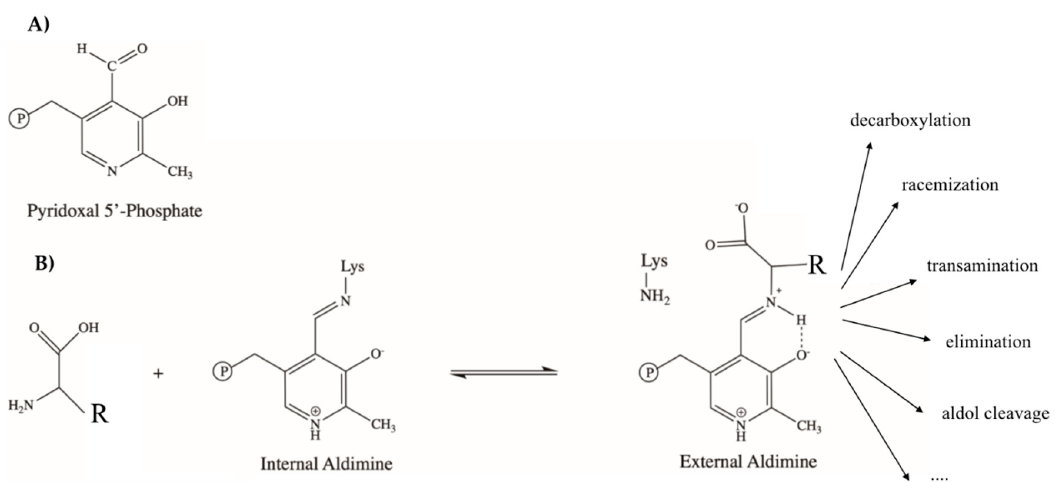
Figure 2. Schematic view of pyridoxal 5 ′ -phosphate (PLP) and catalytic mechanism of PLP enzymes. ( A ) Chemical structure of PLP. ( B ) Schematic depiction of the reaction catalyzed by PLP-dependent enzymes with the possible outcomes.